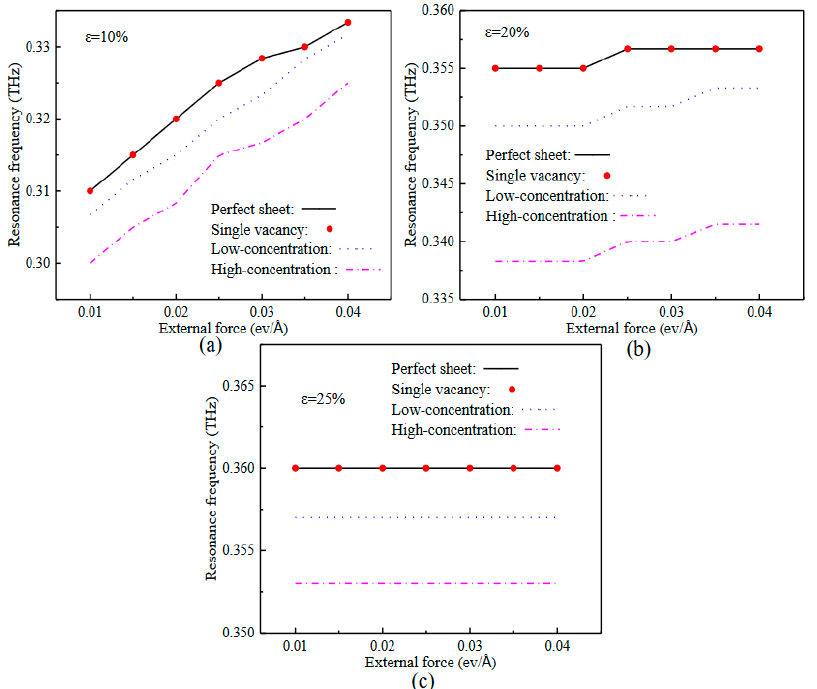
Figure 5. Relationship between the external forces and resonance frequencies of the defective SLGSs at ( a ) linear elastic stage ( ε = 10%), ( b ) nonlinear elastic stage ( ε = 20%), and ( c ) yield stage ( ε =